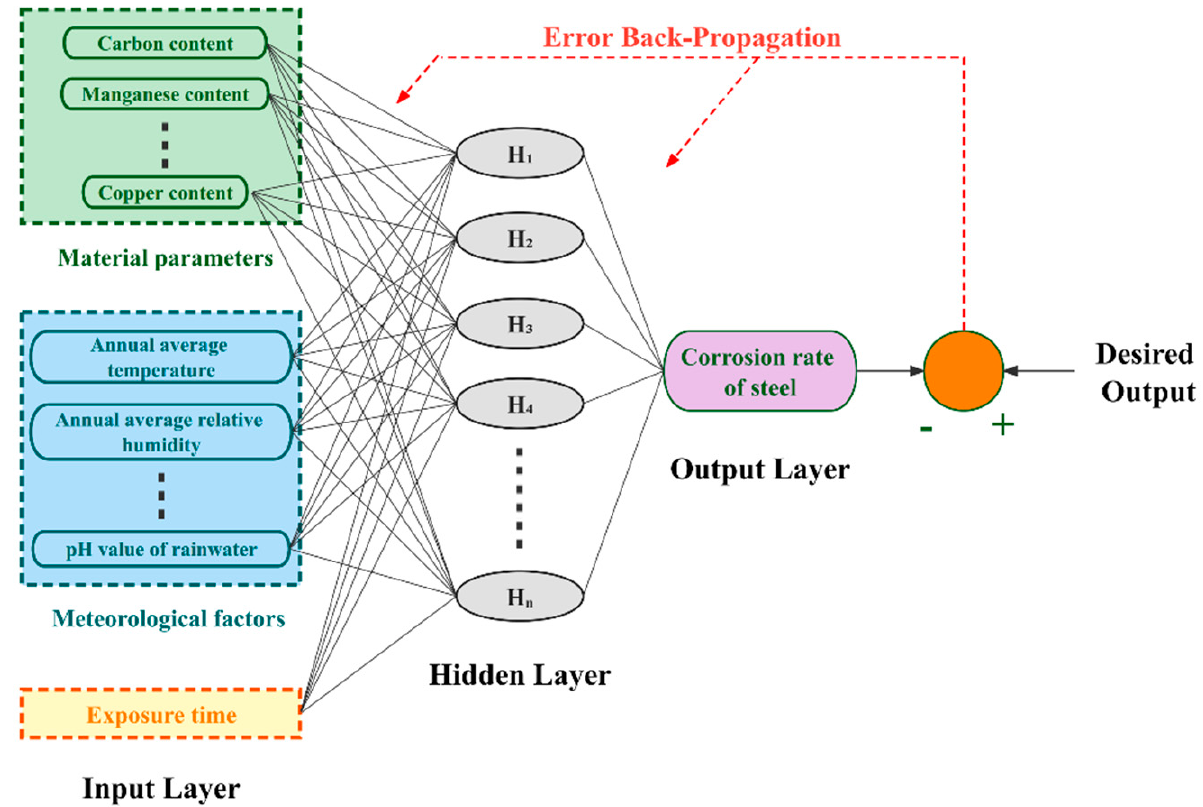
Figure 14. Schematic diagram of the BP artificial neural network. The transfer function of the network was a sigmoid function with a learning rate of 0.05. The interval of the optimal number of hidden layer nodes was determined using existing research [37]. After testing, the number of hidden layer nodes was nine, and a neural network prediction model was obtained through